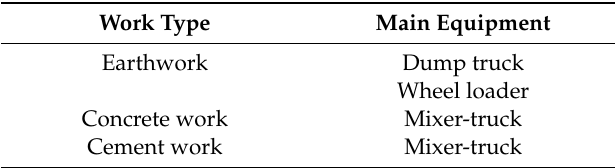
Table 3. Main construction equipment research scope.